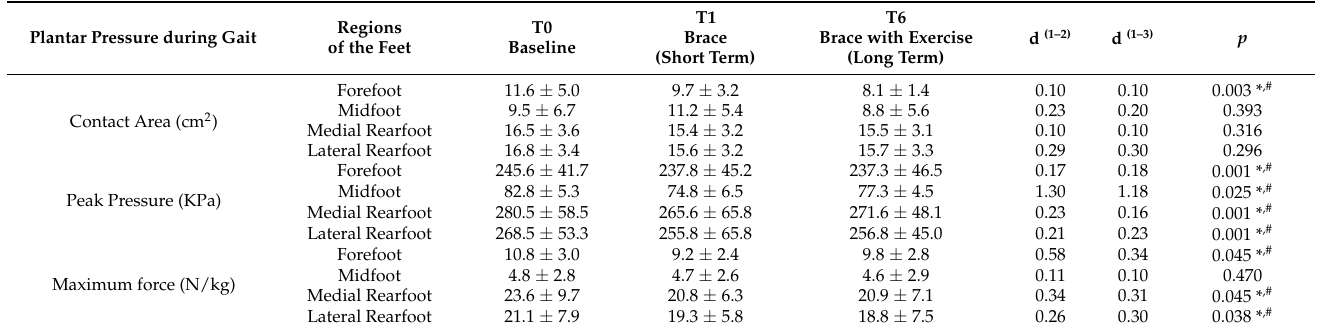
Table 6. Comparisons of plantar pressure distribution during gait between the different time- points: T0—baseline, T1—after immediate use of the spinal orthopedic brace (short term, 24 h), and T6—after six months using a brace associated with specific exercises (long term) in adolescents with idiopathic scoliosis.